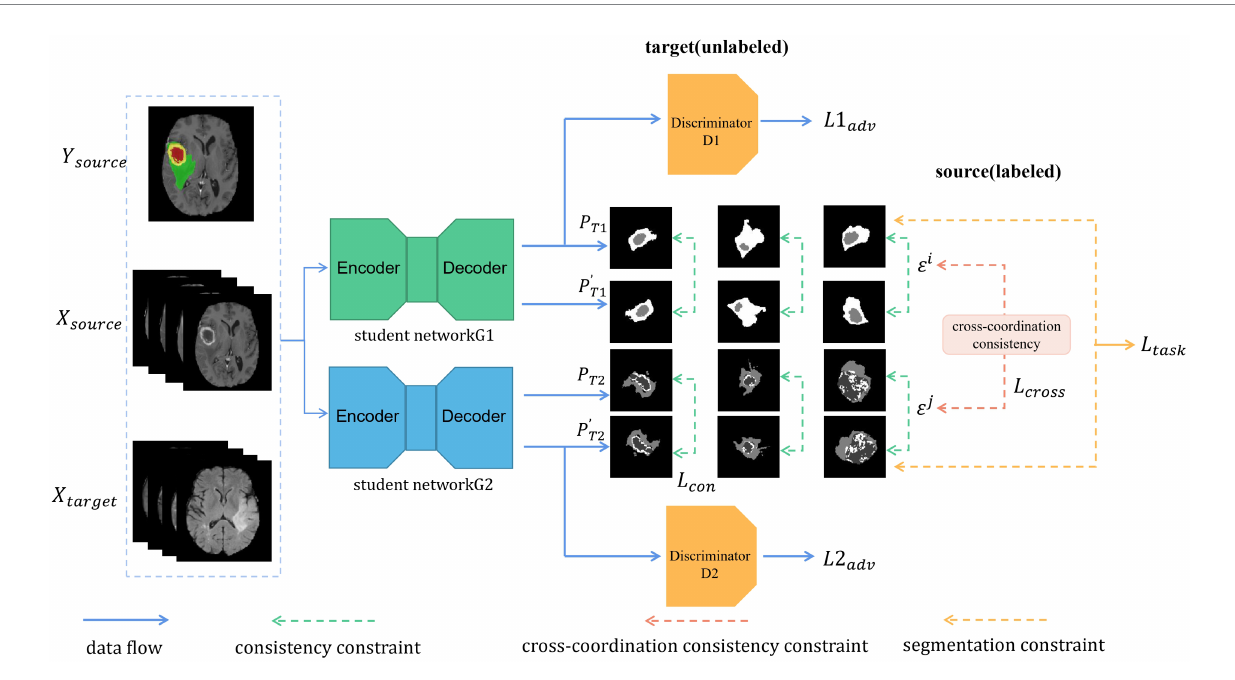
FIGURE 2 Illustration of our proposed architecture. Two models are trained independently. Each batch includes labeled data (from the source domain) and unlabeled data (from the target domain). As unlabeled data, we used the transformed segmentation maps generated with the original images as the input and the alternative segmentation maps generated with the transformed images as the input to meet the consistency constraint. In addition, the cross-coordination constraint is enforced between the students by their prediction and the perturbed one. Furthermore, each student must learn the segmentation task constraint for the labeled